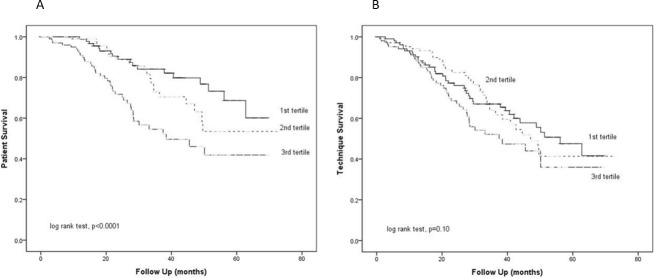
Kaplan-Meier plot of (A) patient survival; and (B) technique survival. Patients were divided into tertiles according to their baseline E:I ratio (1st tertile: ≤0.91; 2nd tertile >0.91–1.07; 3rd tertile >1.07). Data were compared by the log rank test.